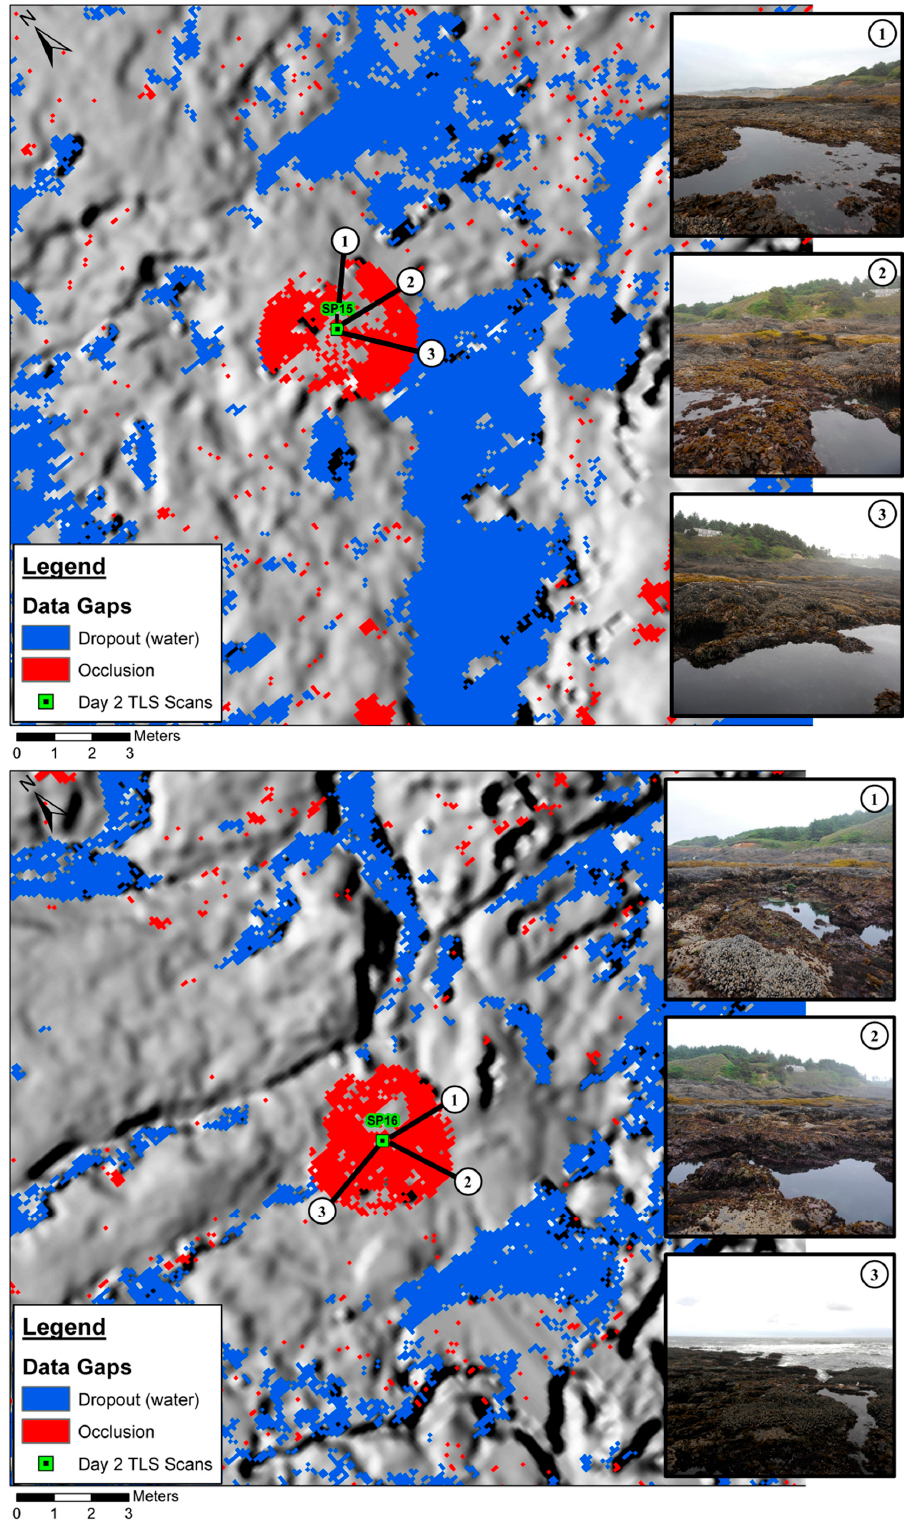
Figure 13. Comparison of results with co-acquired TLS scanner-based imagery for scan positions SP15 (top) and SP16 (bottom).